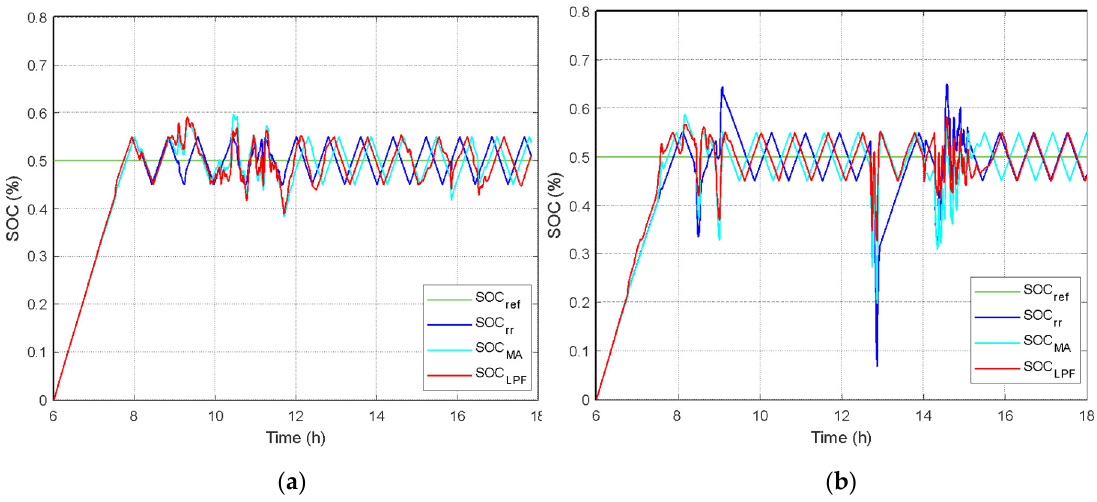
Figure 13. State of charge (SOC) of the storage system, the most critical day: ( a ) the intermediate fluctuation day (23 November 2018), and ( b ) day with less fluctuation irradiance (24 November 2018).